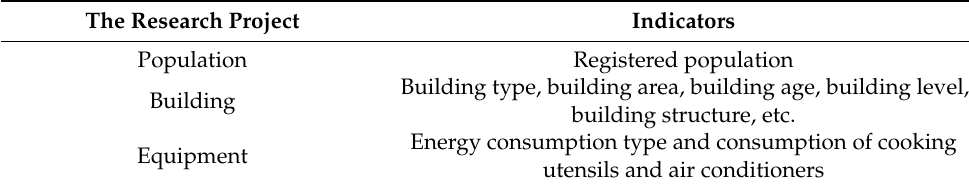
Table 1. Household survey contents.